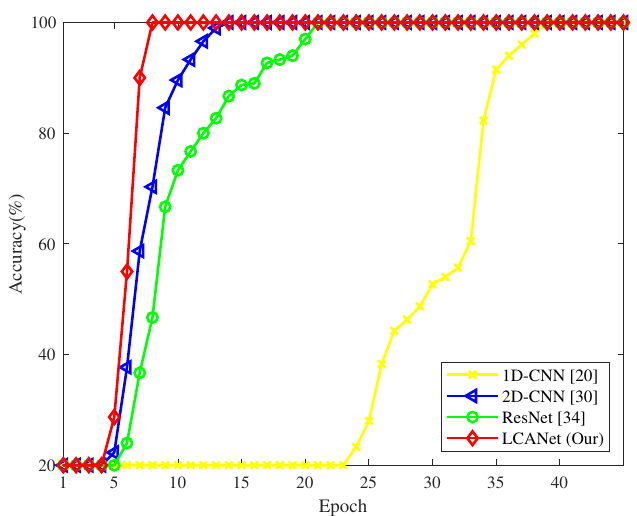
Figure 10. Accuracy of damaged area detection using LACNet and contrast models.